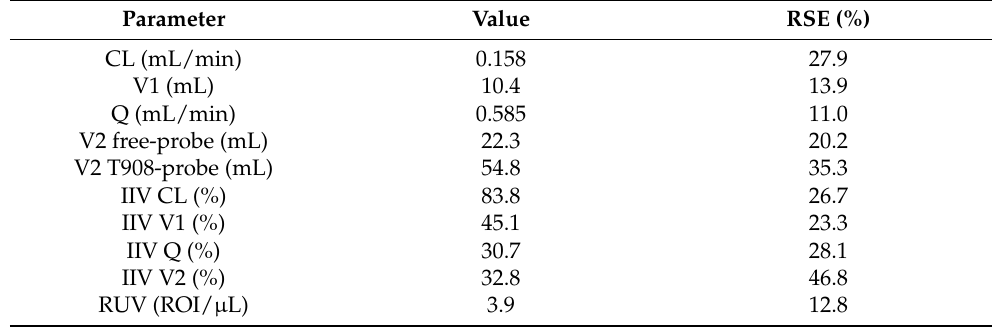
Table 3. Typical parameter values are reported for an animal with 25 g body weight. IIV stands for inter-individual variability, RUV stands for residual unexplained variability (described with an additive error model), and RSE (%) stand for the relative standard error quantifying the uncertainty in parameter estimation. Pharmacokinetic parameters: elimination clearance (CL), distribution clearance (Q), volume of distribution of the central compartment (V1), and volume of distribution of the peripheral compartment (V2). Parameter